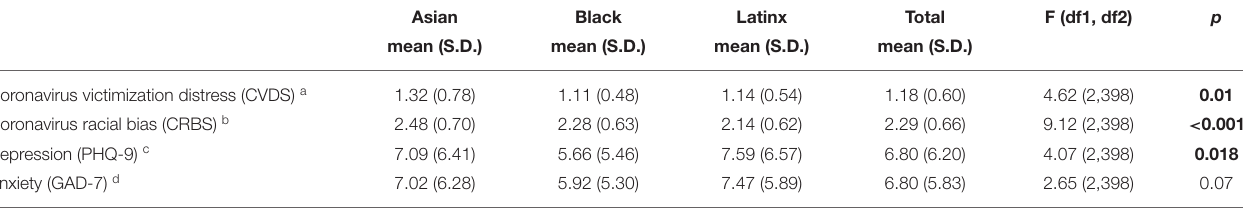
TABLE 2 | Means, SD, and range for coronavirus victimization distress scale (CVDS), coronavirus racial bias scale (CRBS), PHQ-9 and GAD-7 for each racial/ethnic group. Asian Black Latinx Total F (df1, df2) p mean (S.D.) mean